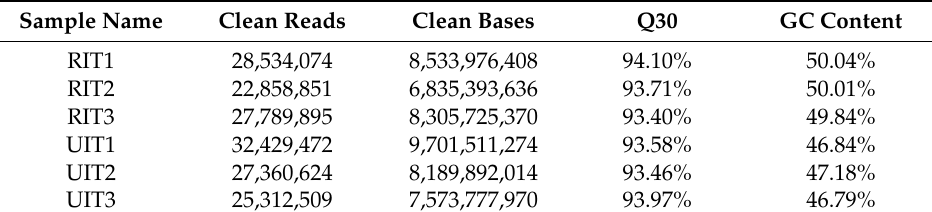
Table 2. Descriptive statistics of sequencing data.